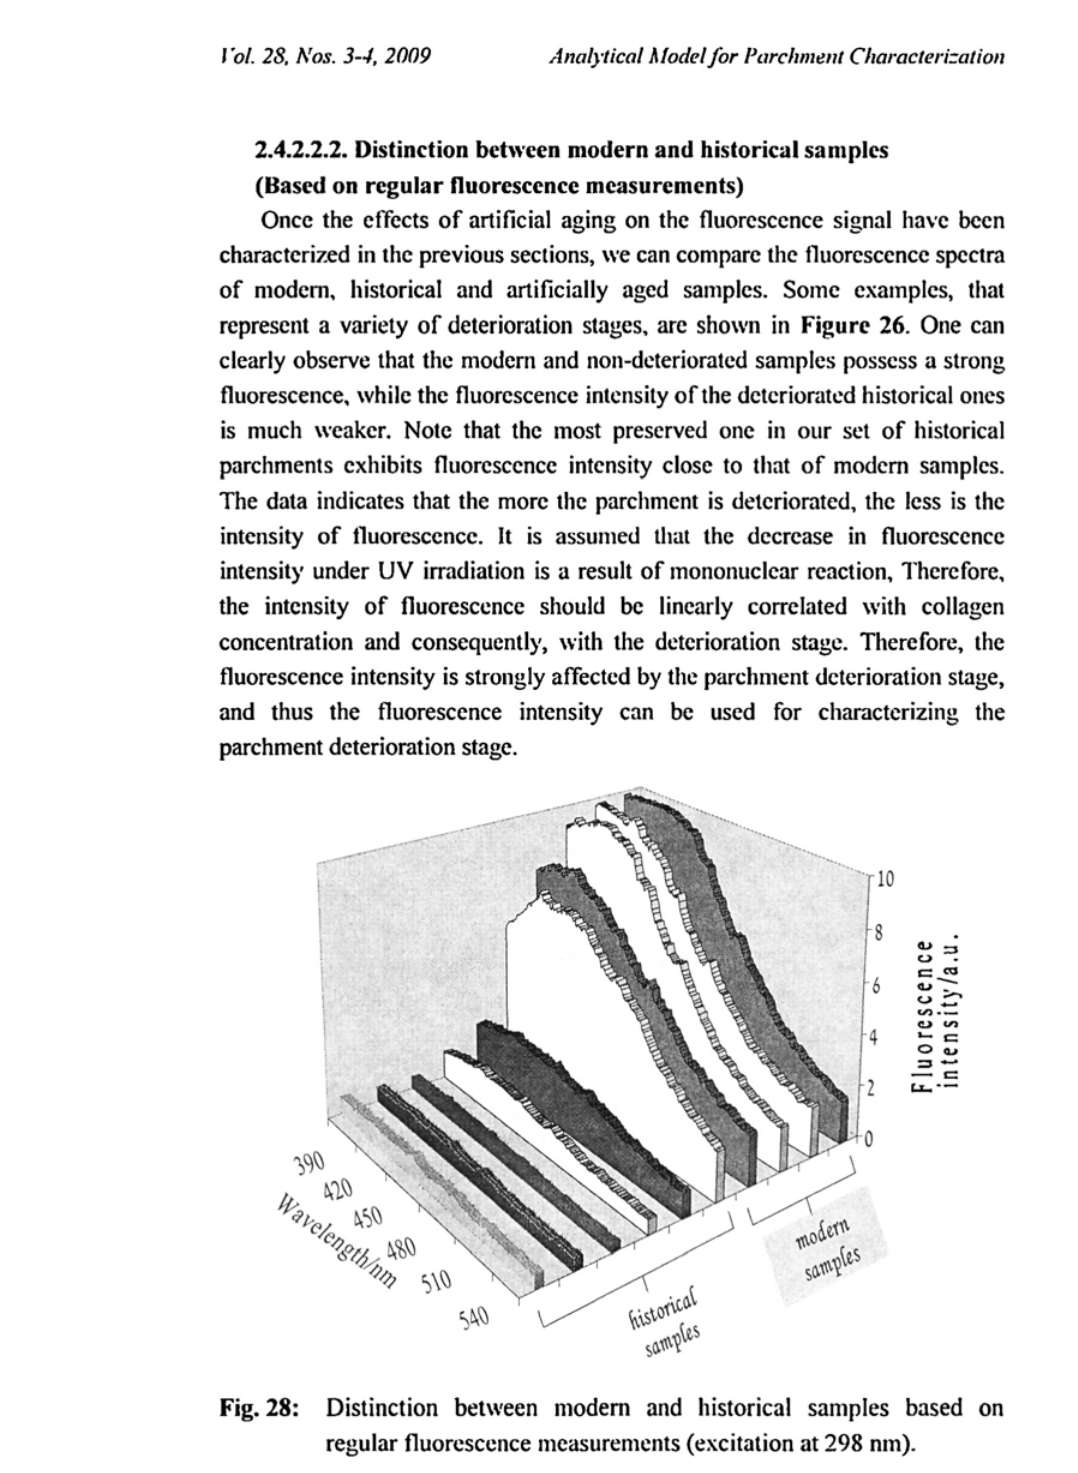
Fig. 28: Distinction between modern and historical samples based on regular fluorescence measurements (excitation at 298